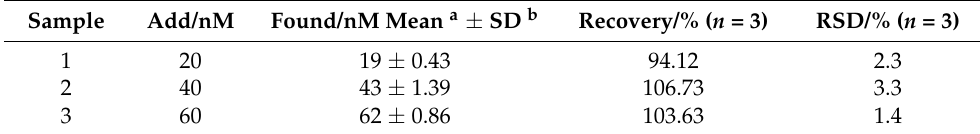
Table 1. Human serum recovery test for miR-10b